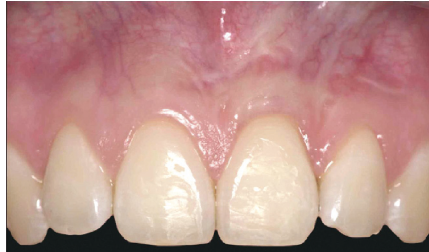
Figure 7: Clinical conditions one year after surgical intervention. If compared to baseline, a significant reduction of gingival recession could be